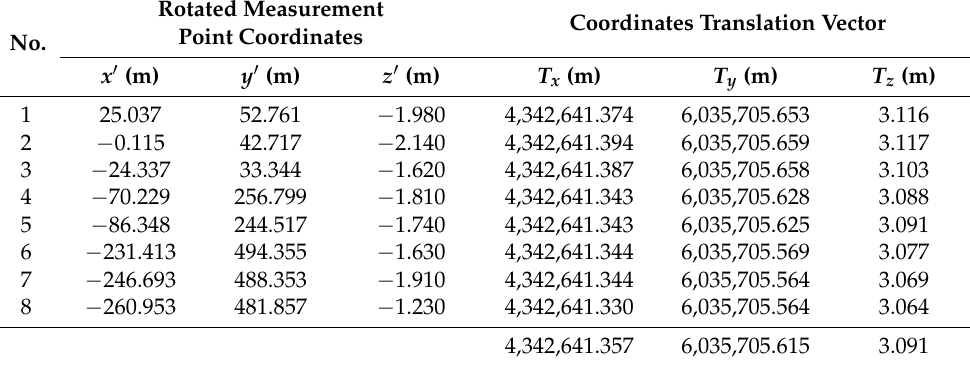
Table 6. Rotated measurement point coordinates and their translation